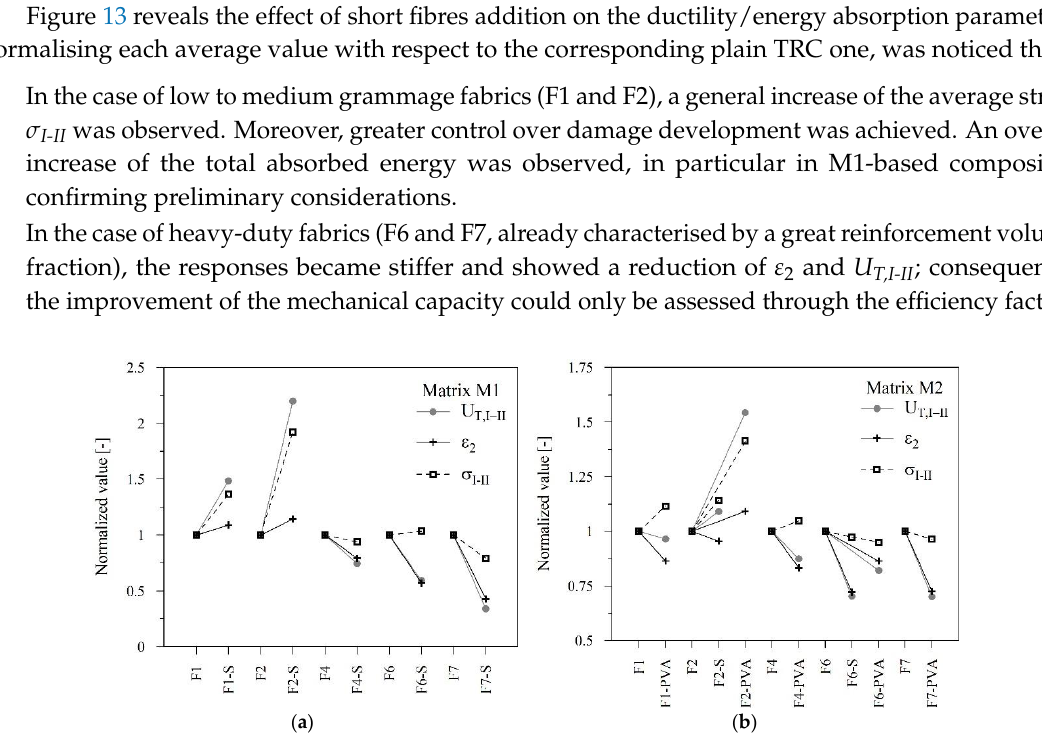
Figure 13. Ductility/energy absorption parameters in uniaxial tension for M1-based ( a ) and M2-based ( b ) TRC composites: effect of fibres addition. ( b ) TRC composites: effect of fibres